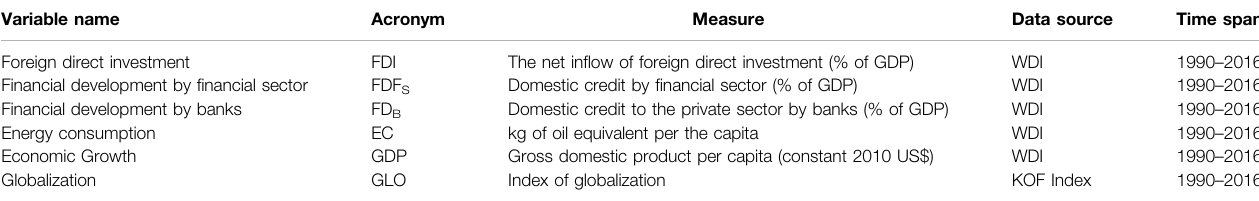
TABLE 1 | Variables, measure, data source, and time